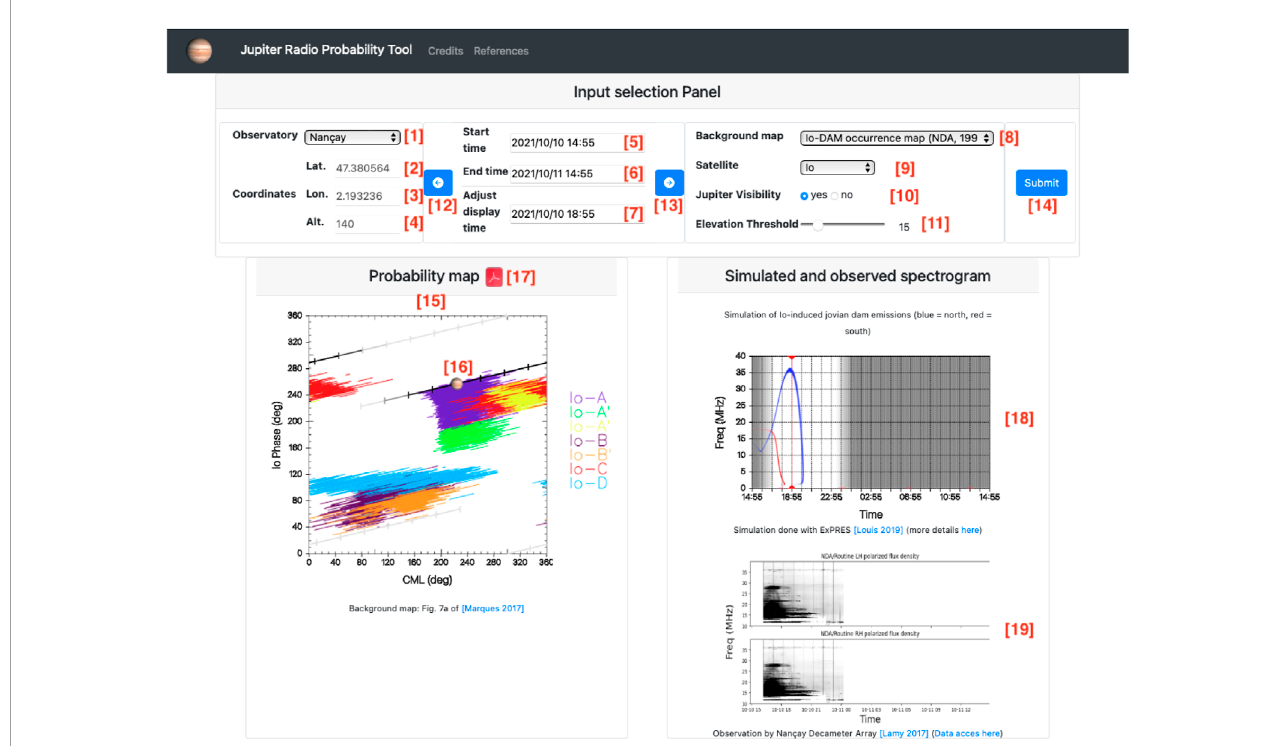
FIGURE 3 Screenshot of the online application. The numbers are referring to the numbered items in Table 1 .